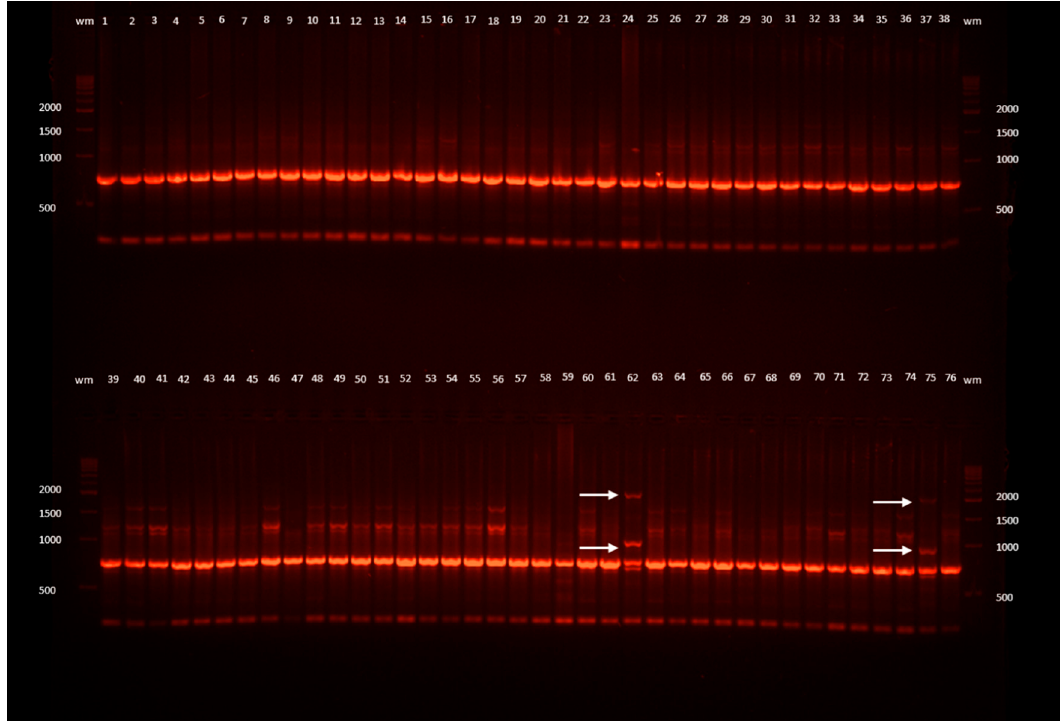
Figure 1. Example ISSR band profiles of L. spectabilis ‘Gold Heart’ received as a result of electrophoresis of the DNA amplification products obtained with the I-D primer. Outermost lanes (wm) are DNA bp weight markers; 1, 2, 3, ... are the numbers of the plants: 1–29 recovered after encapsulation-vitrification (EV) cryopreservation, 30–54 after droplet-vitrification (DV), 55–70 after vitrification (V), 71–76 untreated control plants (C); arrows point to changed band profiles.